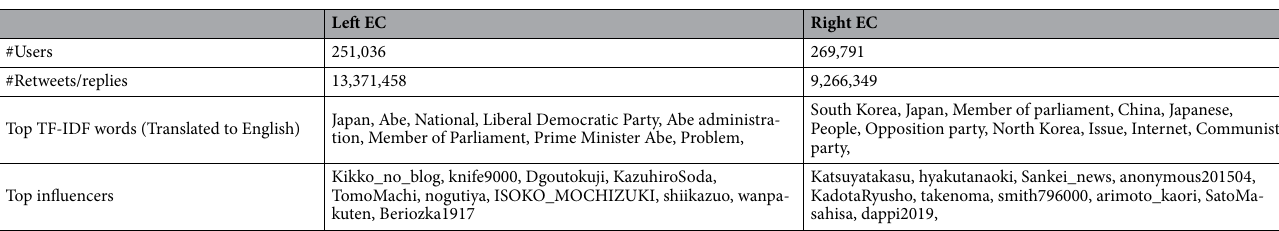
Table 1. Details of the left- and right-leaning